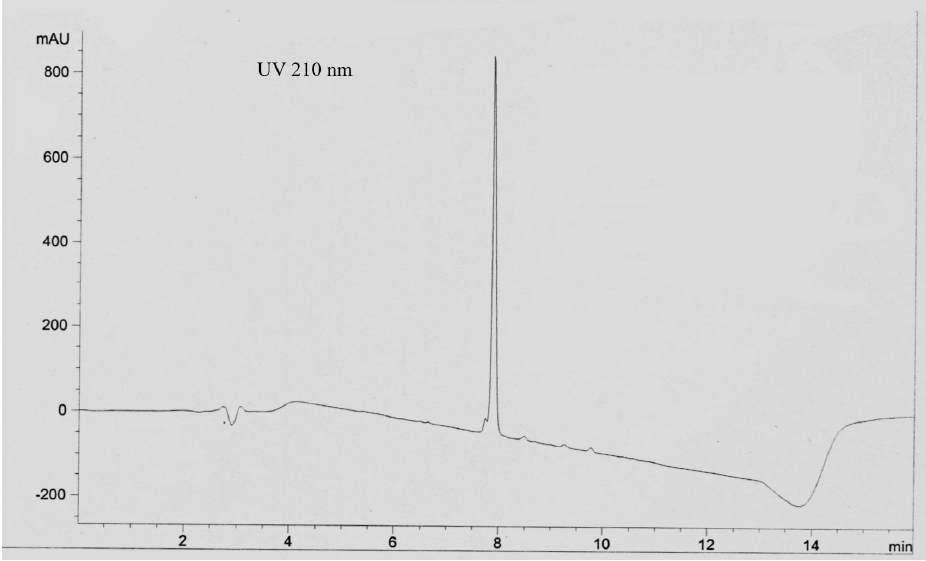
Figure 1. An RP HPLC analysis of the “echimidine” peak from E. plantagineum under acidic conditions (0.05% TFA). This peak in fact consists of Echimidine, Echihumiline and Hydroxymyoscorpine. However, further NMR and HPLC data analysis indicated that this single peak com- prises a mixture of alkaloids. Using the “core-shell” RP HPLC column (Kinetex EVO C18, was resolved into two well-separated peaks (Figure 2). Peak A consists of echihumiline and hydroxymyoscorpine, whereas peak B represents echimidine.